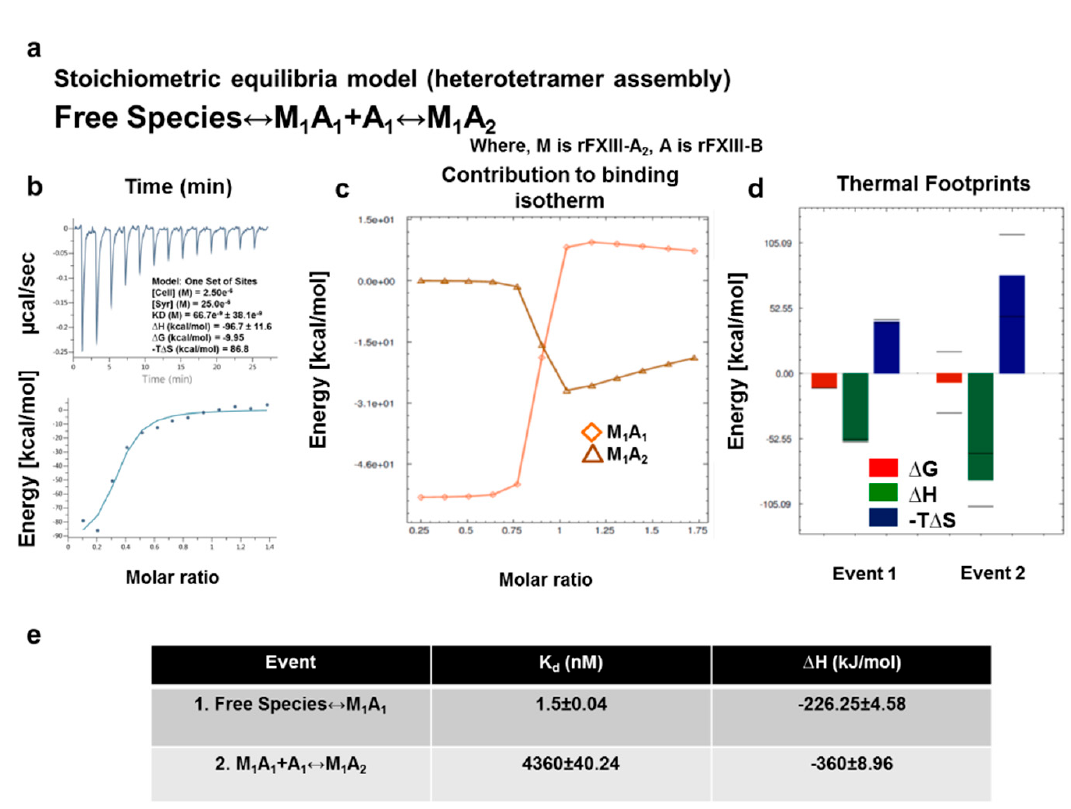
Figure 6. In-solution associations of FXIII subunits studied by ITC. ( a ) is the equation depicting the stoichiometric binding equilibrium model, followed for the analysis of data derived from ITC (model was generated in A ffi nimeter using model builder approach). ( b ) represents the titration of 2.5 µ M rFXIII-A 2 (in cell), with 25 µ M FXIII-B subunits (in syringe). The upper image of this panel is the raw data depicting the heat change upon each injection; the lower image in this panel is the normalized data, with integrated heat change plotted against the concentration ratio of rFXIII-B vs. rFXIII-A 2. (blank controls not shown). A solid black line represents the corresponding fit obtained in Origin software using one-set of binding mode. ( c , d ) are based on A ffi nimeter analyses depicting the contribution of individual reactants of the equation ( a ) towards the isotherm. The heat signatures depicting the free energy changes, changes in enthalpy, and entropy in the two events explained in ( a ), respectively. ( e ) is a table explaining the two thermodynamic events, and their corresponding dissociation constants (K d ) and changes in enthalpy ( ∆